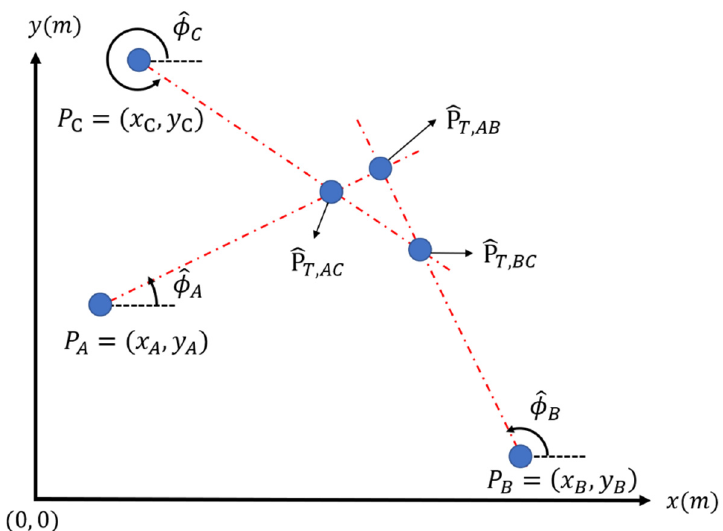
Figure 4. Triple base stations localization system.